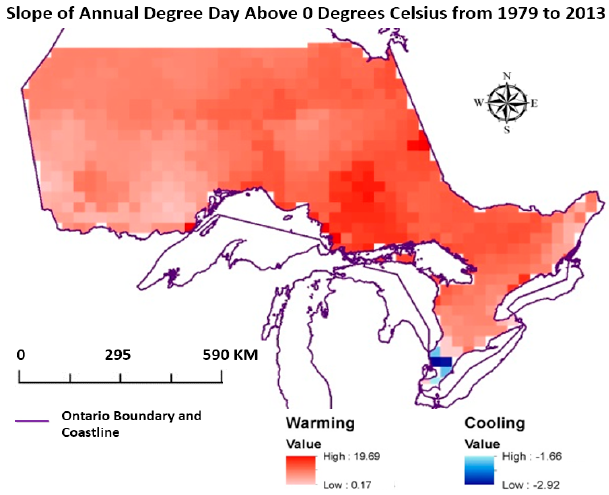
Figure 2. Change in mean monthly temperature in southern Ontario between 1979 and 2013. Data was obtained from the MOD11C3 land surface temperature product.